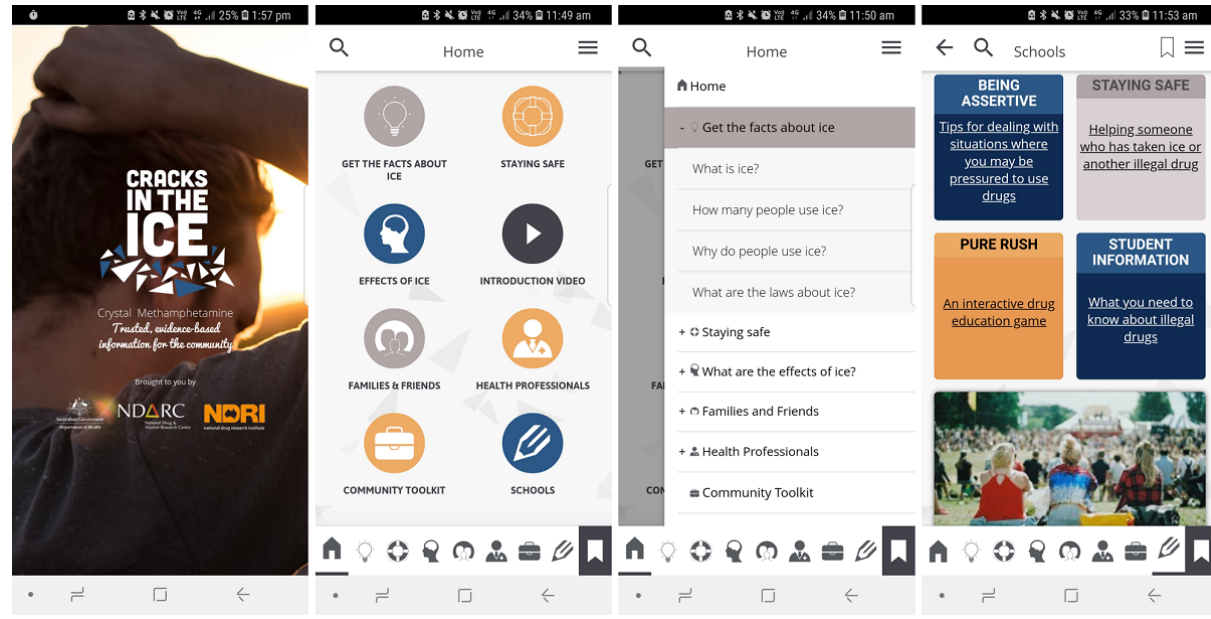
Figure 4. Screenshots of Cracks in the Ice mobile app when released to the public January 2018. Source: Cracks in the Ice App Version 1. Developers: National Health and Medical Research Council Centre of Research Excellence in Mental Health and Substance Use and Netfront Pty Ltd. Licensed under fair